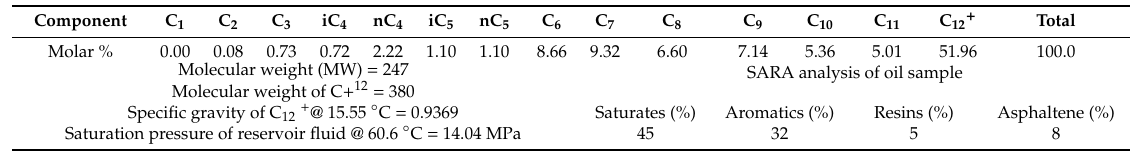
Table 2. Properties of the crude oil used in this